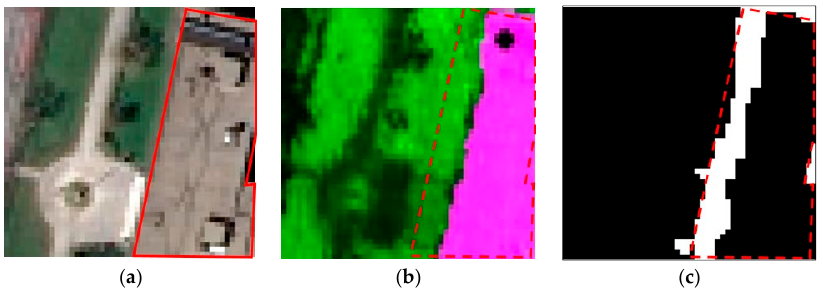
Figure 9. The spatial correspondence for the mis-registration areas between multi-temporal LiDAR data and the high-resolution image: ( a ) high-resolution image; ( b ) LiDAR data; and, ( c ) mask for no-data area. The red rectangle indicates the schematic object from the high-resolution image.